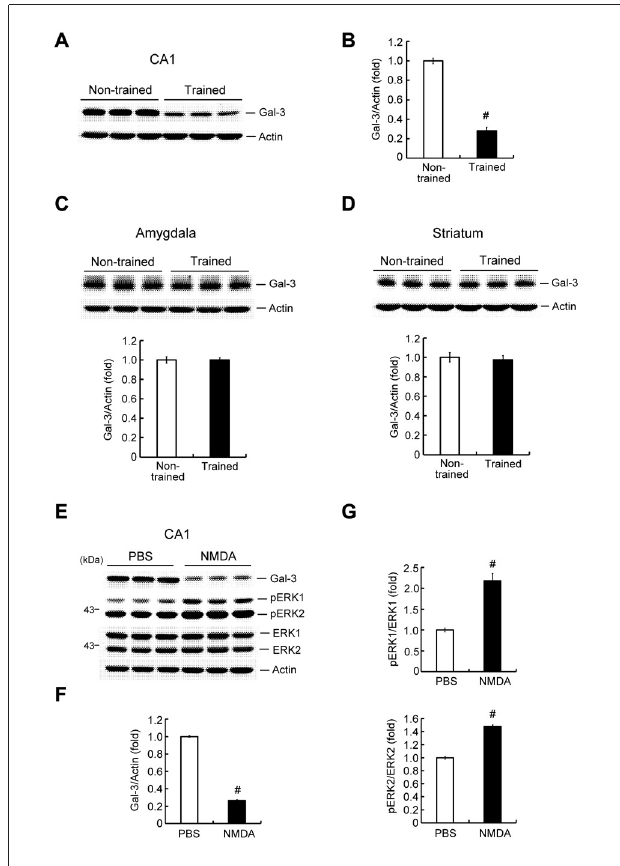
FIGURE 2 | Contextual fear-conditioning training and NMDA decrease galectin-3 expression in the rat hippocampus. (A) Western blot showing galectin-3 expression in the CA1 area of trained and non-trained rats. (B) Quantitative analysis of galectin-3 expression in CA1 area of trained and non-trained rats ( t ( 1,18 ) = 15.27, P < 0.001). (C) Western blot and quantitative analysis of galectin-3 expression in the amygdala of trained and non-trained rats ( t ( 1,18 ) = 0.02, P > 0.05). (D) Western blot and quantitative analysis of galectin-3 expression in the striatum of trained and non-trained rats ( t ( 1,18 ) = 0.38, P > 0.05). N = 10 each group. (E) Western blot showing the effect of NMDA injection (12.5 mM) on the expression level of galectin-3 and pERK in rat CA1 area. Quantitative analysis of the effect of NMDA on (F) Galectin-3 expression ( t ( 1,10 ) = 51.11, P < 0.001) and (G) pERK1/ERK1, pERK2/ERK2 levels ( t ( 1,10 ) = 6.69, P < 0.001 for pERK1 and t ( 1,10 ) = 15.12, P < 0.001 for pERK2) in the CA1 area. N = 6 each group. Data are mean ± SEM. # P <